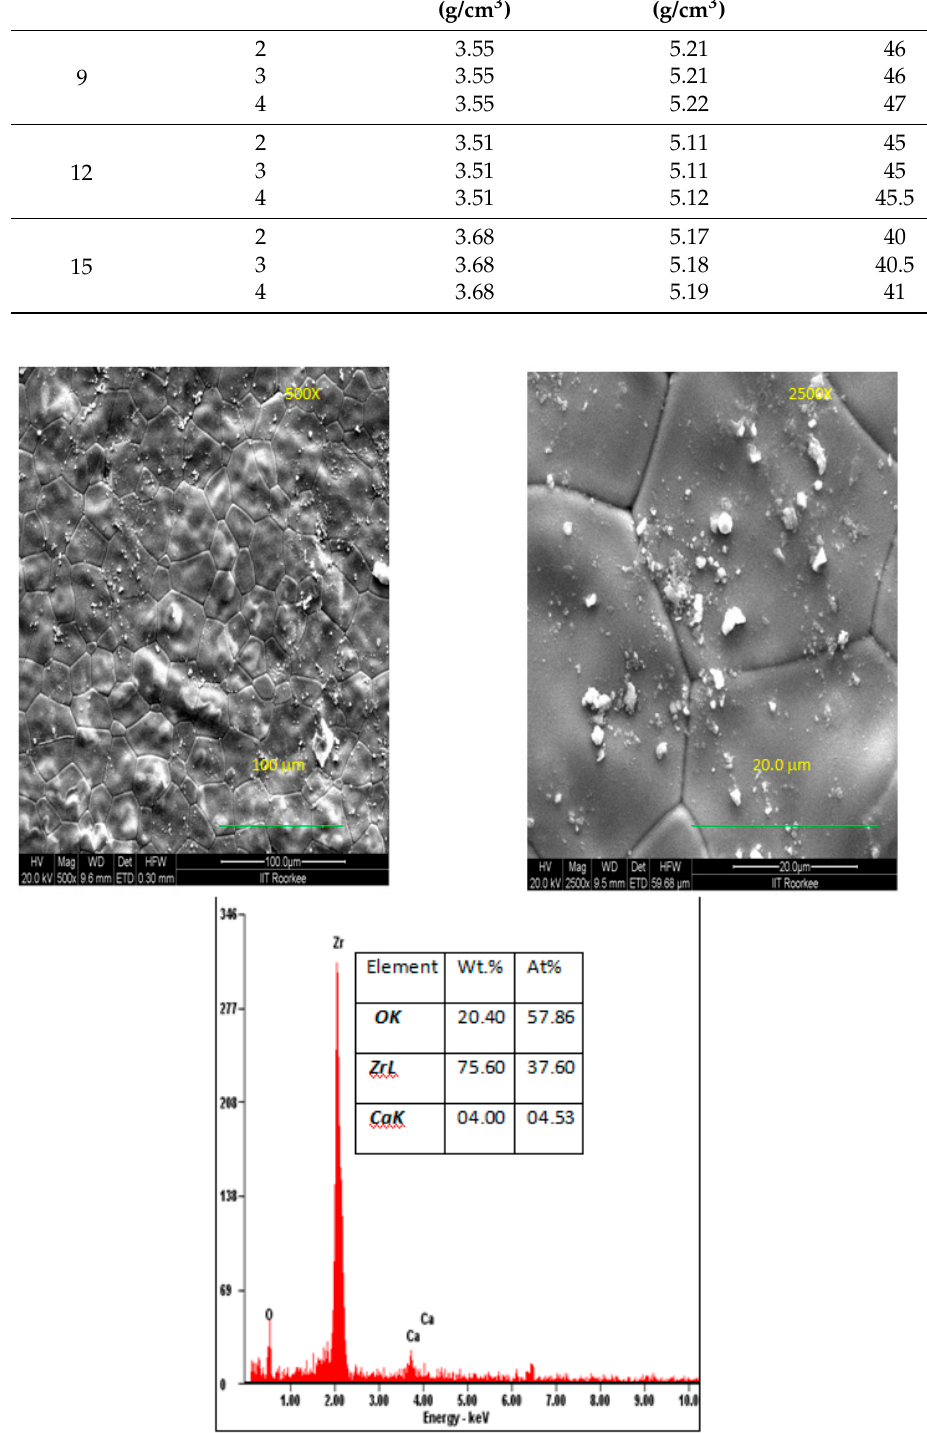
Figure 4. Nine mol% CaO-stabilised zirconia SEM and EDS.